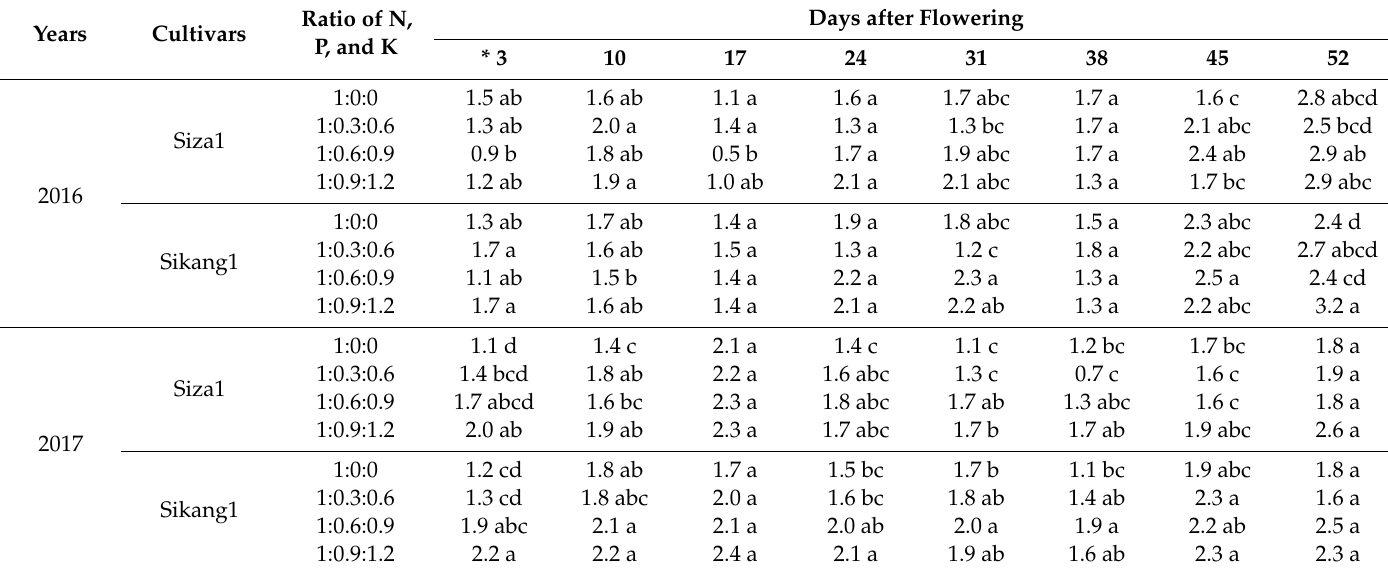
Table 7. E ff ects of the ratio of nitrogen, phosphorous, and potassium application on dry boll shell weight (g) of two cotton cultivars Siza 1 and Sikang 1 in 2016 and 2017. Ratio of N, Years Cultivars P, and